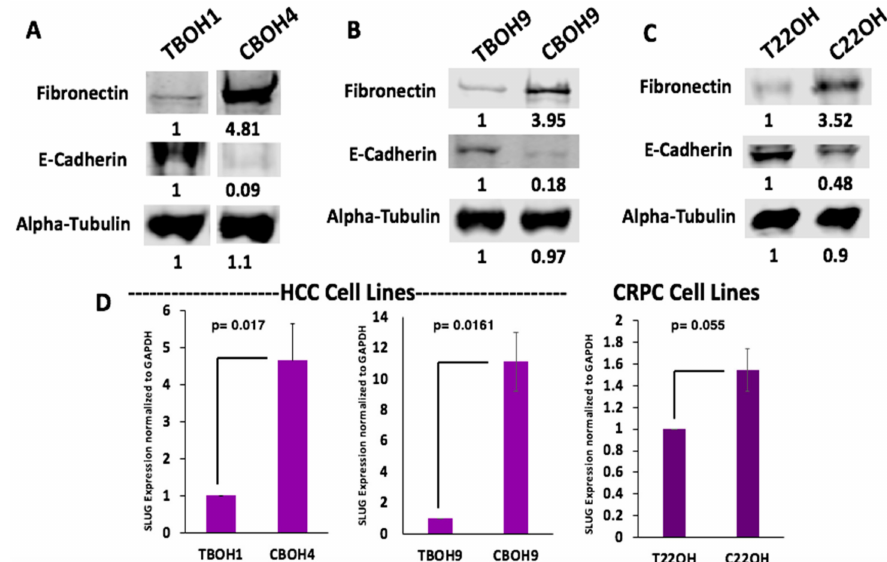
Figure 4. CTCs undergo epithelial-to-mesenchymal transition (EMT) as observed by increased fibronectin, decreased E-cadherin, and increased SLUG expression. ( A , B ) Fibronectin and E-cadherin protein expression by HCC primary tumor-derived cell lines and CTC lines. ( C ) Fibronectin and E-cadherin protein expression by CRPC primary tumor-derived cell line and CTC line. ( D ) SLUG expression was assessed using qPCR. Expression was normalized against GAPDH. Data provided on graphs are presented as mean ± standard error of the mean (SEM); N =